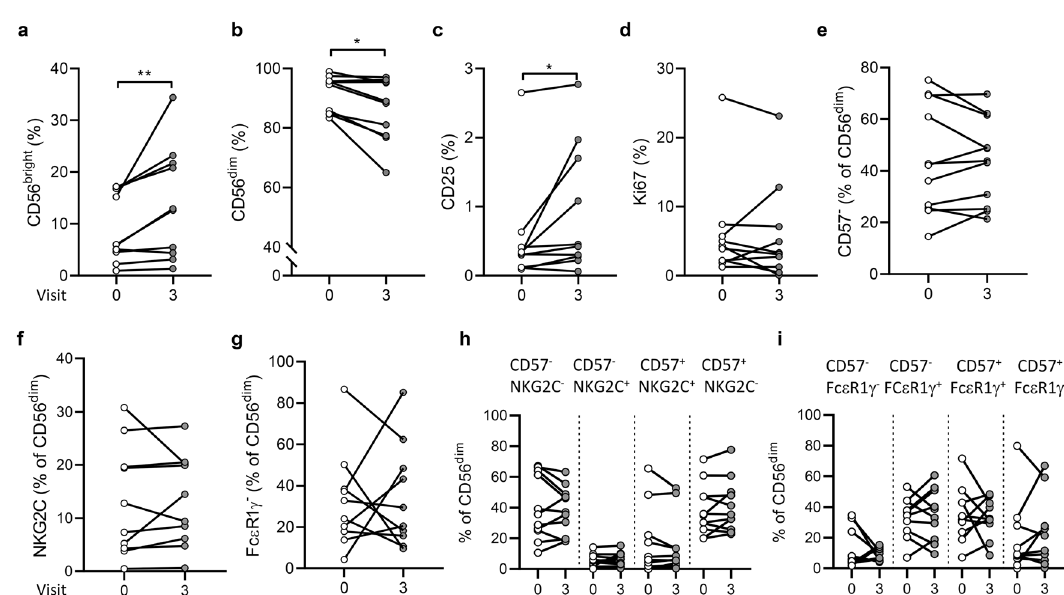
Fig. 1 Ex vivo analysis of NK cell subsets and activation markers. Frequencies of CD56 bright ( a ), CD56 dim ( b ), CD25 ( c ), and Ki67 ( d ) expressing NK cells and frequencies of CD57 − ( e ), NKG2C + ( f ), Fc ε R1 γ − ( g ), CD57/NKG2C ( h ), and CD57/Fc ε R1 γ ( i ) de fi ned subsets within CD56 dim NK cells, between visit 0 (baseline) and visit 3 (180 days post-dose 2). Vaccination groups were pooled for analysis. Paired data points are shown for individual study participants as before and after plots ( n = 10). Comparisons were made using Wilcoxon signed-rank test. * p < 0.05, ** p <